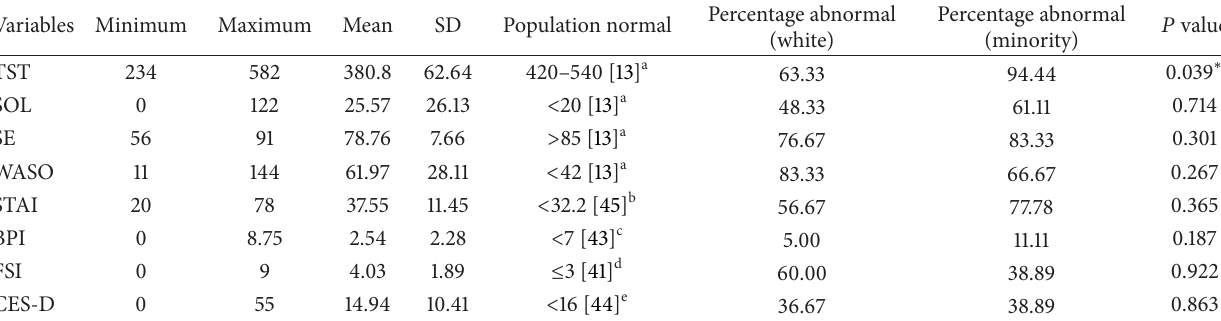
Table 2: Descriptive statistics of actigraphy parameters, physical and psychological symptoms of participants by race/ethnicity ( 𝑁 = 78 ). Variables Minimum